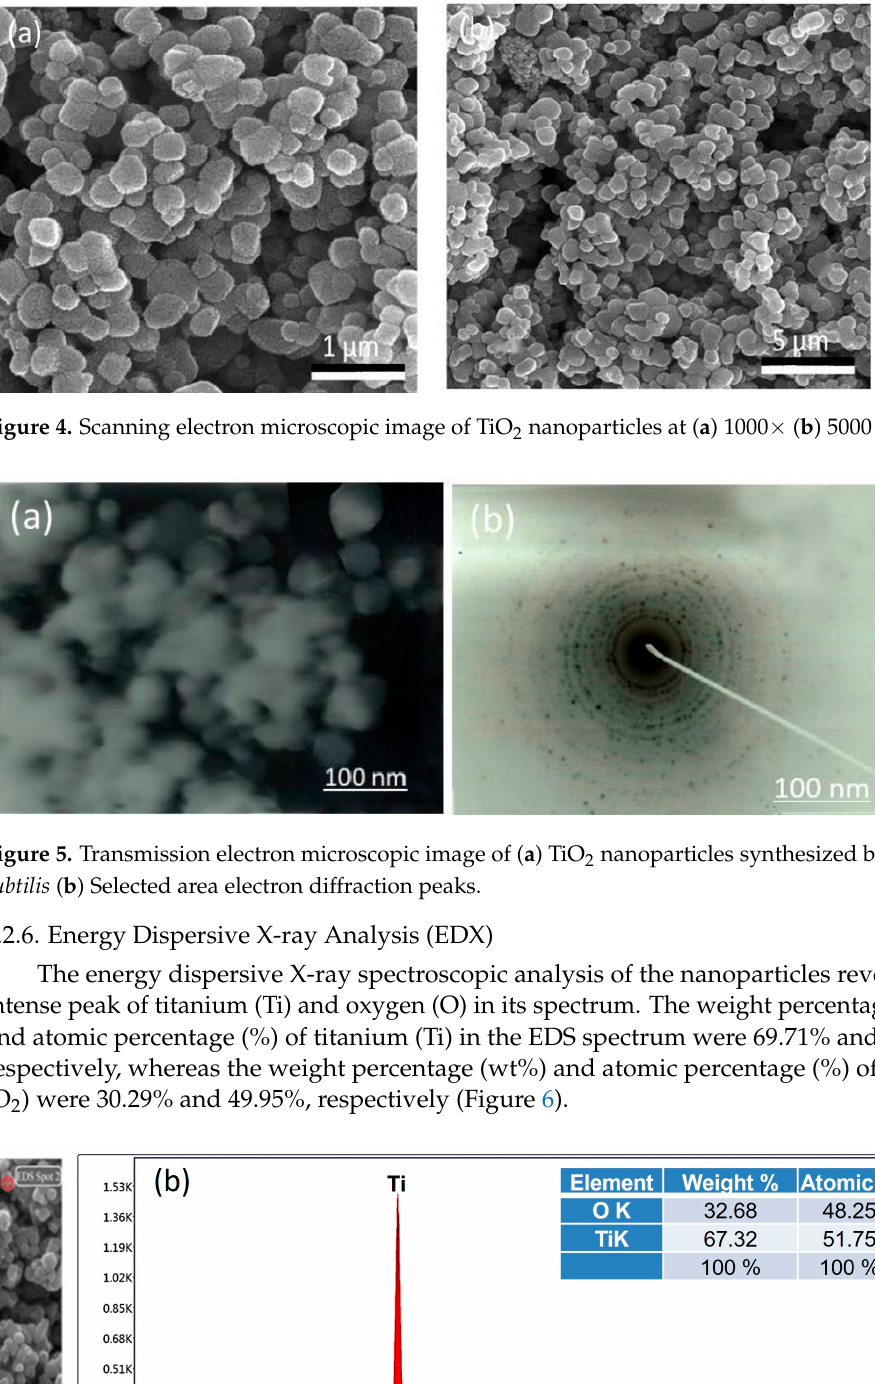
Figure 4. Scanning electron microscopic image of TiO 2 nanoparticles at ( a ) 1000× ( b ) 5000×.